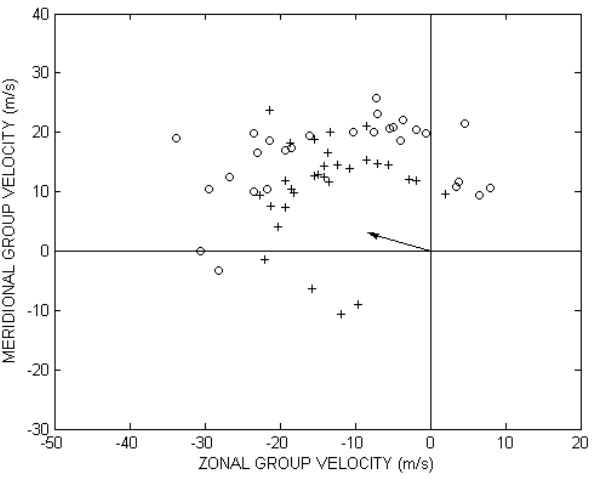
Fig.7 Same as Fig.6 except that these gravity wave packets were selected from the Fig. 7. Same as Fig. 6 except that these gravity wave packets were summer data set in Fig.5. selected from the the summer data set in Fig. 5.